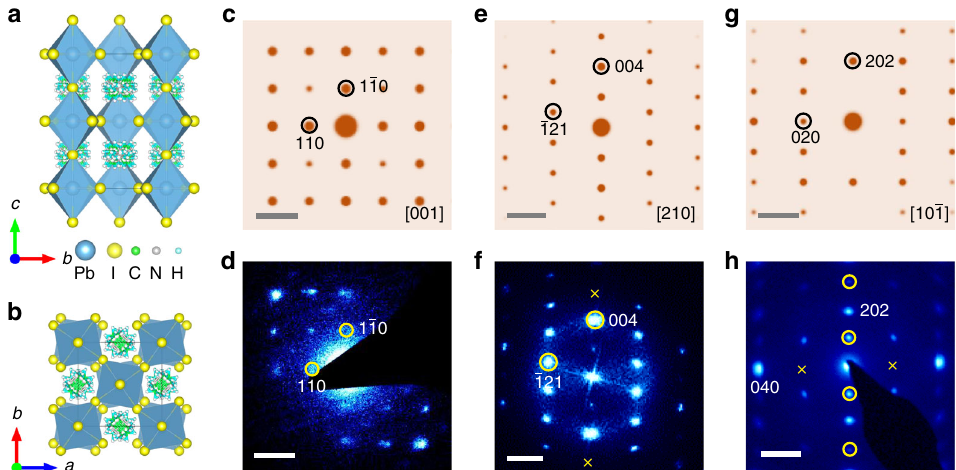
Fig. 1 The atomic structure of tetragonal MAPbI 3 . The atomic models of tetragonal MAPbI 3 along a [100] and b [001] zone axis. The simulated electron diffraction (ED) patterns of tetragonal MAPbI 3 along c [001], e [210], and g [10 (cid:1) 1] zone axes, respectively. d , h The selected area electron diffraction (SAED) and f fast Fourier transform (FFT) pattern of tetragonal MAPbI 3 . Note that there is a subtle difference between the experiment and simulation. The {110} diffraction spots appear to be dimmer in d , and the (002) spot almost vanishes and the (006) spot disappears marked by yellow crosses in f , and the (020) spot is not observed marked by yellow crosses but additional {2h + 1, 0, 2h + 1} re fl ections [e.g., (101)] appear indicated by yellow circles in h . Scale bar, 2 nm − 1 ( c – h